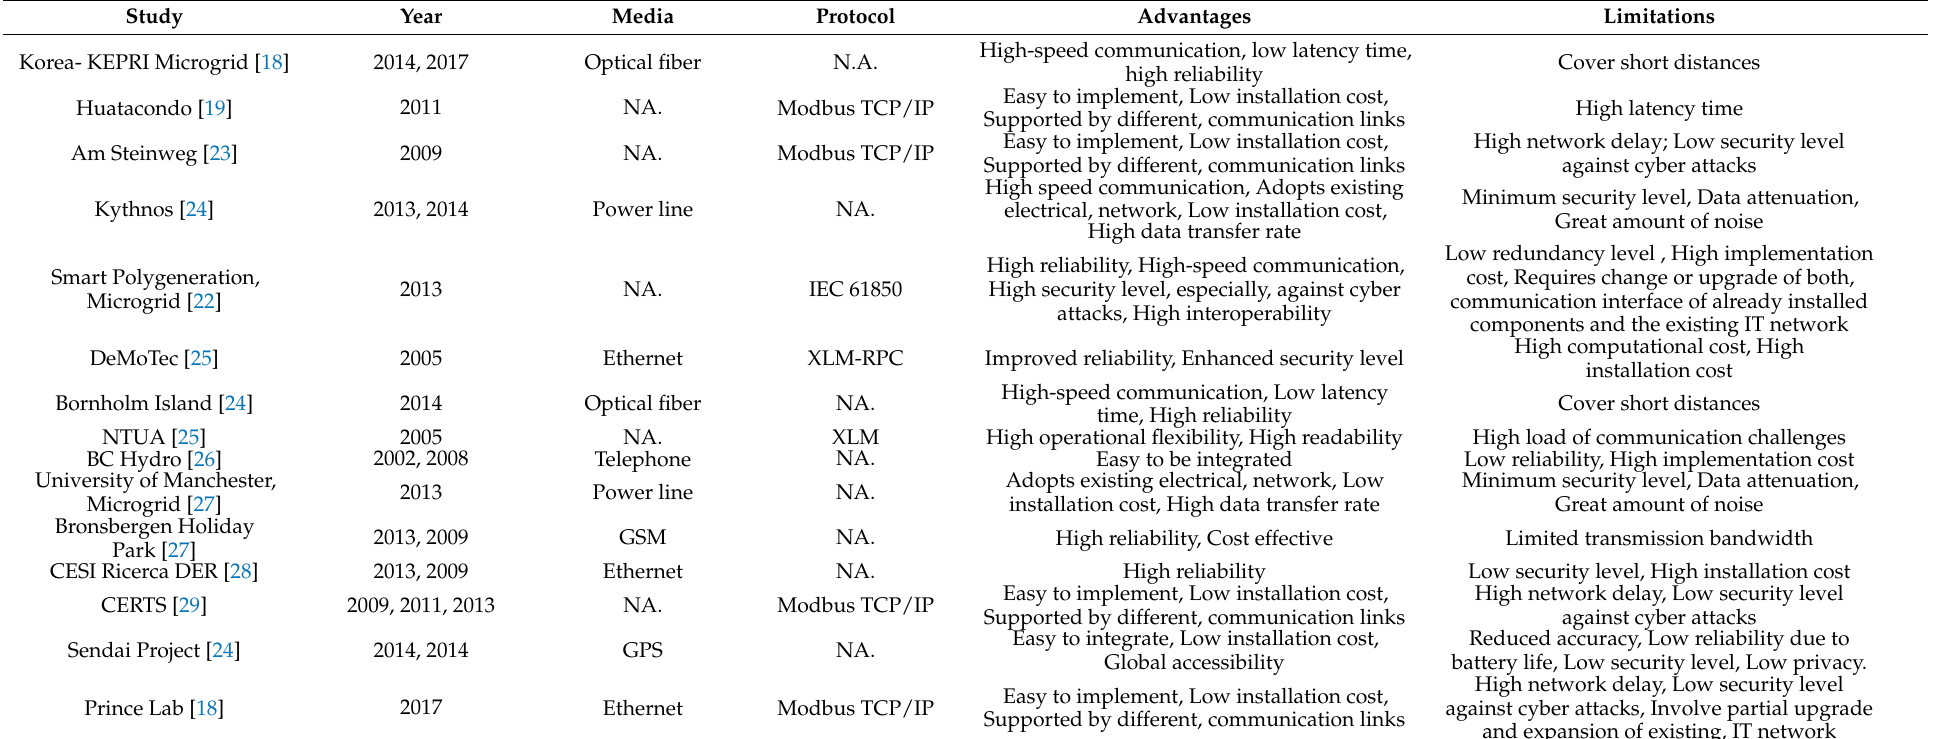
Table 1. A summary of the advantages and limitations of microgrid communication protocols based on selected related